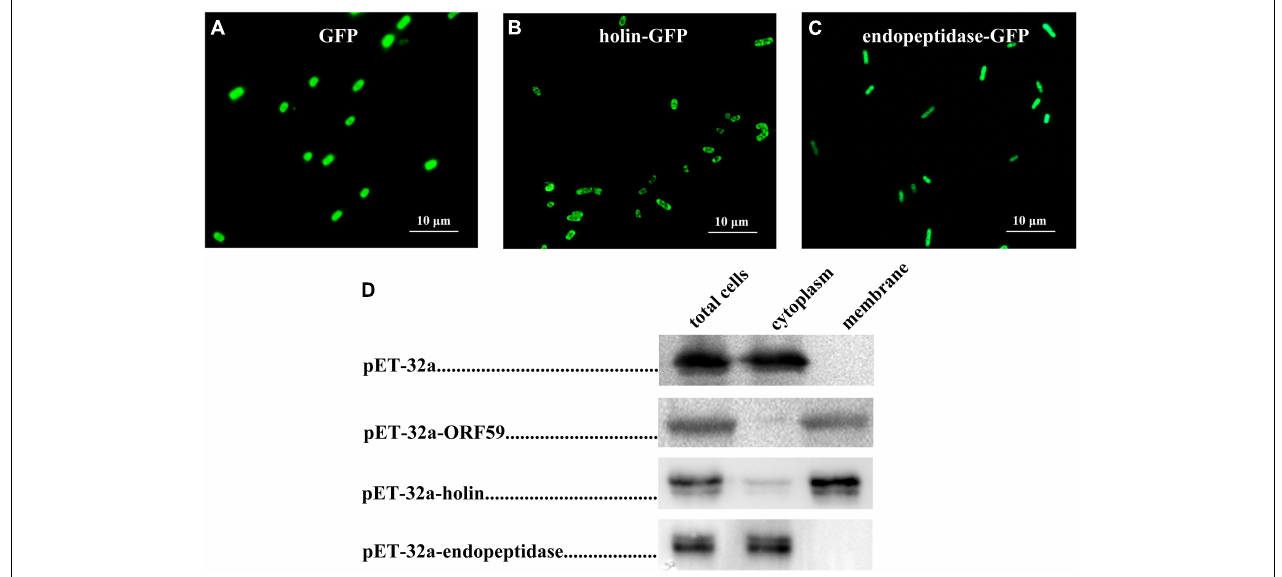
FIGURE 1 | Localization of holin and endopeptidase in Escherichia coli . (A) Fluorescence image of E. coli (DE3: pET32a-GFP) expressing GFP. (B) Fluorescence image of E. coli (DE3: pET-32a-holin - GFP) expressing holin - GFP. (C) Fluorescence image of E. coli (DE3: pET-32a-endopeptidase - GFP) expressing endopeptidase - GFP. (D) The subcellular localization of holin and endopeptidase were analyzed using Western blotting.